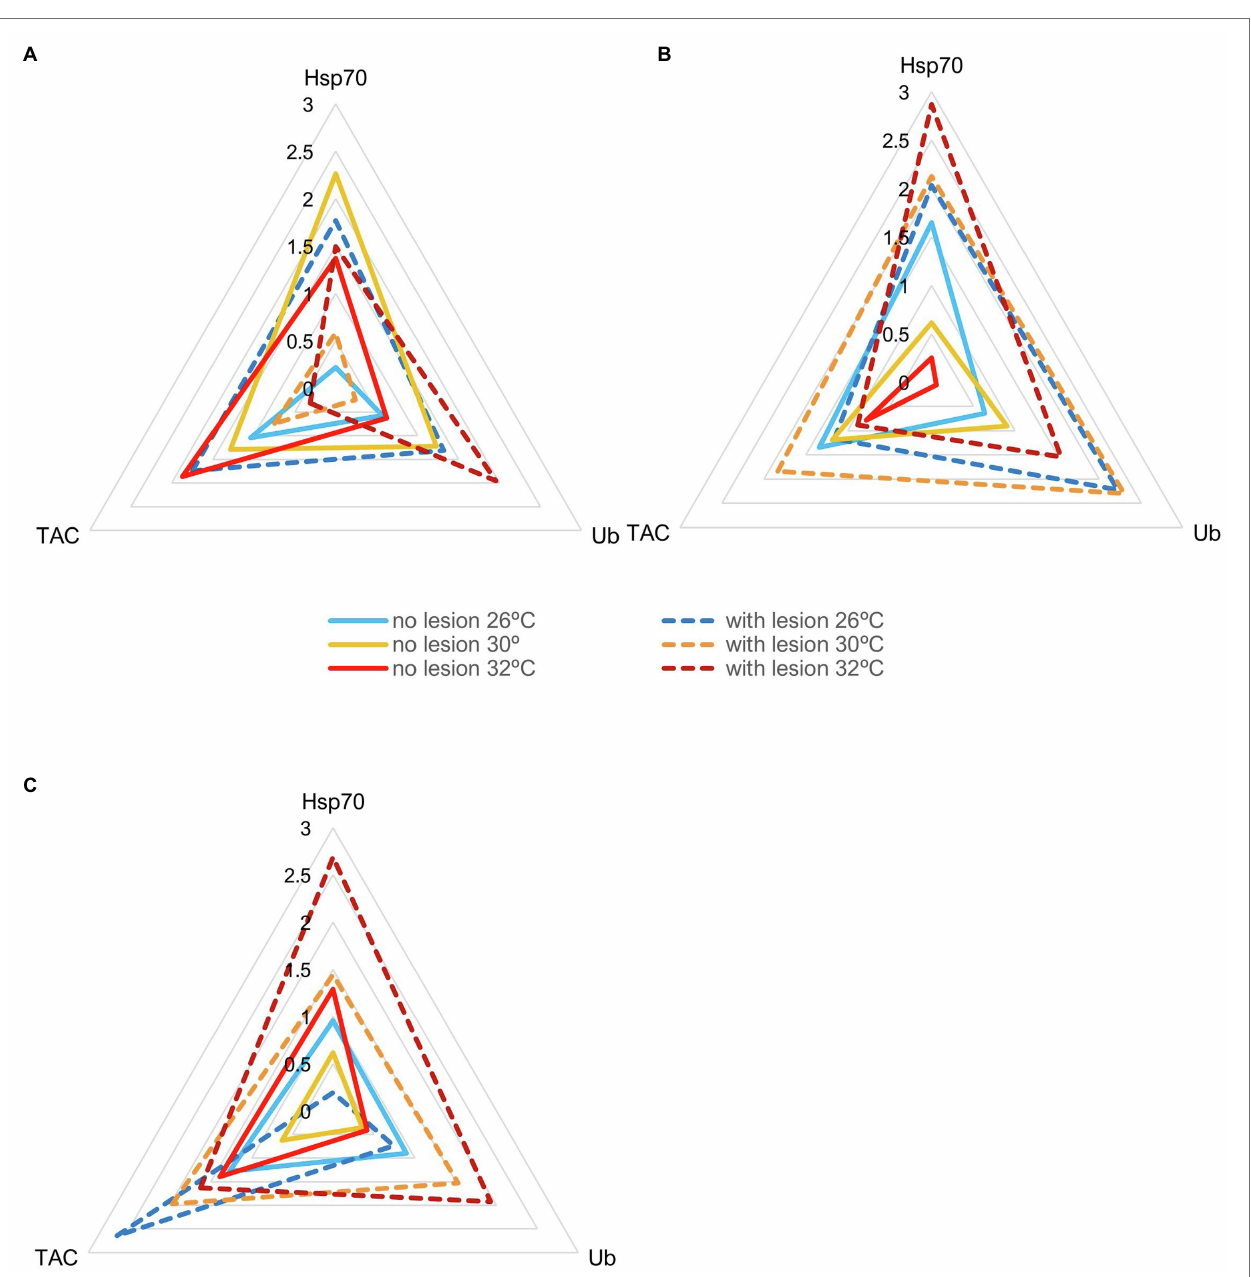
FIGURE 6 | Star plots with mean scores obtained in each experimental condition for thermotolerant coral species that survived up to 32 ° C (N total = 30 fragments per species, N = 5 specimens of each species per experimental condition). (A) Galaxea fascicularis (IBR 26 + no lesion = 0.47; IBR 26 + lesion = 3.85; IBR 30 + no lesion = 3.63; IBR 30 + lesion = 0.37, IBR 32 + no lesion = 2.28; IBR 32 + lesion = 1.99); (B) Psammocora contigua (IBR 26 + no lesion = 2.05; IBR 26 + lesion = 4.74; IBR 30 + no lesion = 1.17; IBR 30 + lesion = 6.50, IBR 32 + no lesion = 0.13; IBR 32 + lesion = 4.16); and (C) Turbinaria reniformis (IBR 26 + no lesion = 1.60; IBR 26 + lesion = 1.30; IBR 30 + no lesion = 0.41; IBR 30 + lesion = 4.03, IBR 32 + no lesion = 1.44; IBR 32 + lesion =